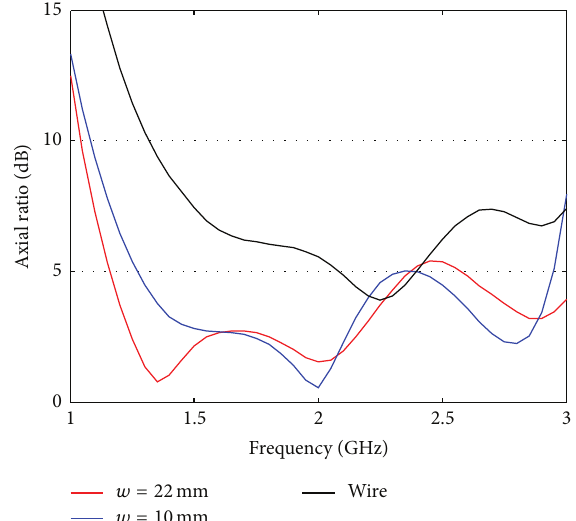
Figure 5: Axial ratio against frequency when the helix is made of strips and wire.